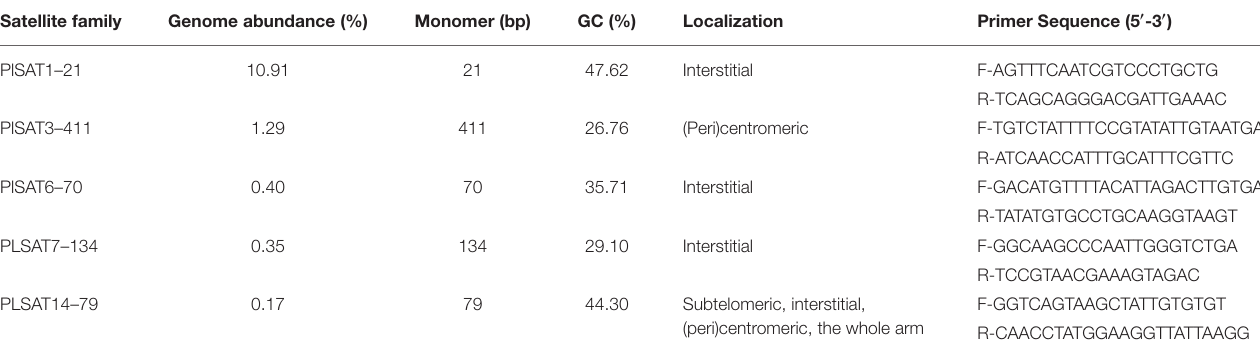
TABLE 2 | Characterization of selected satellite DNA families in P. leptodactylus . Satellite